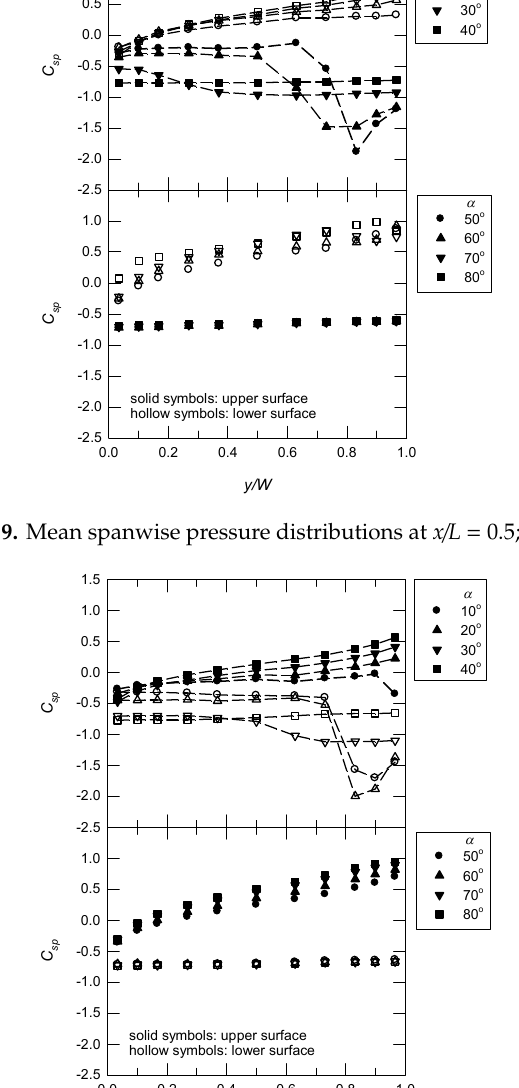
Figure 10. Mean spanwise pressure distributions at x/L = 0.5; β = 135°.